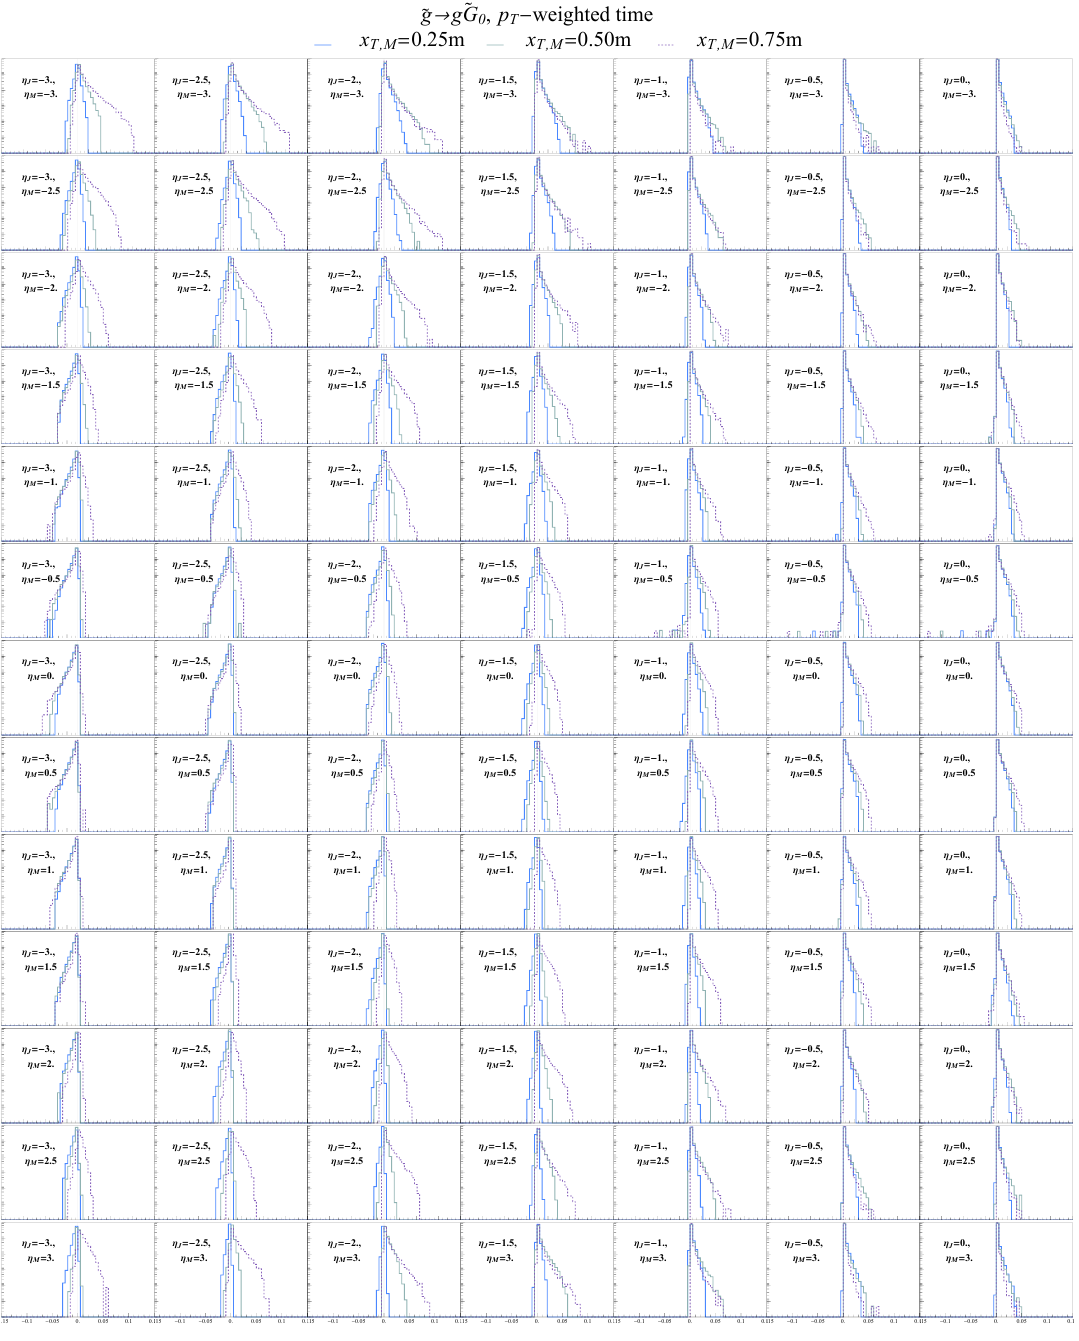
Figure 21 . The relative time difference distribution for x T,M = 0 . 25 m (blue), x T,M = 0 . 50 m (gray), and x = 0 . 75 m (purple dashed) times as a function of η T,M for the p -weighted time. The vertical axis in each plot is in log-scale and ranges from 10 − 5 to T